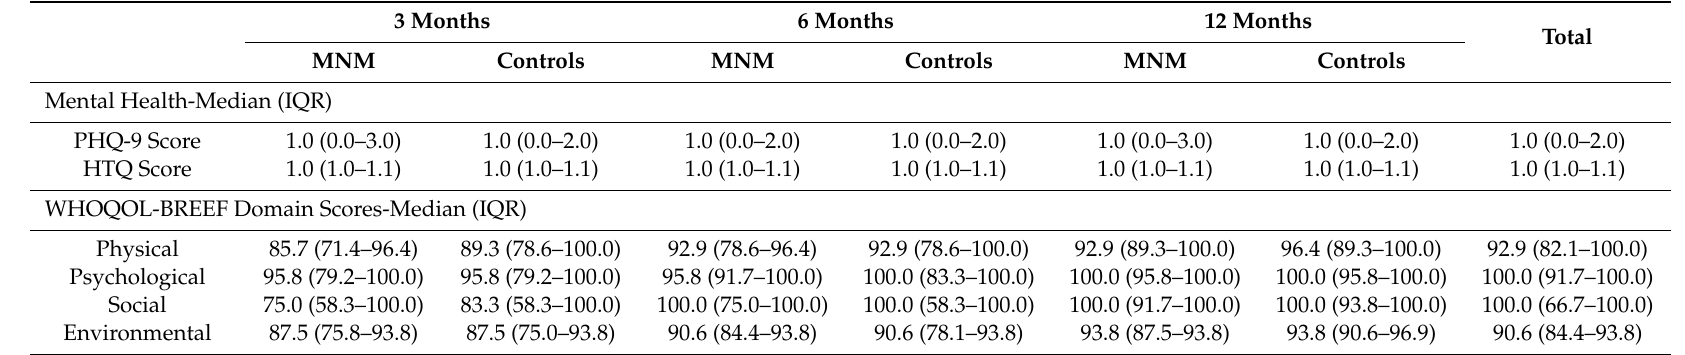
Table 2. Descriptive results of outcome variables over time for maternal near-miss versus control